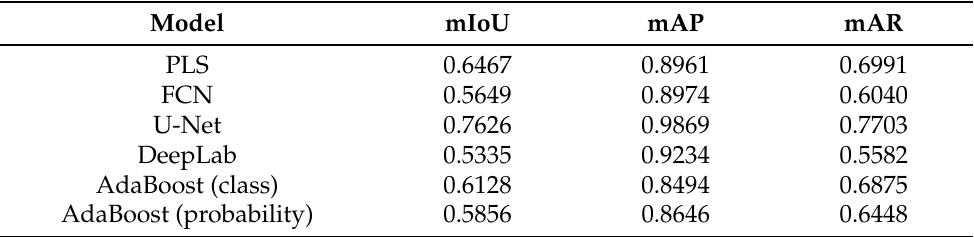
Table 1. Segmentation accuracy of each model. The validation of the models was performed with a dataset consisting of selected images from the Hybrid Thresholding Algorithm (HYTA) and Singapore Whole Sky Imaging Segmentation